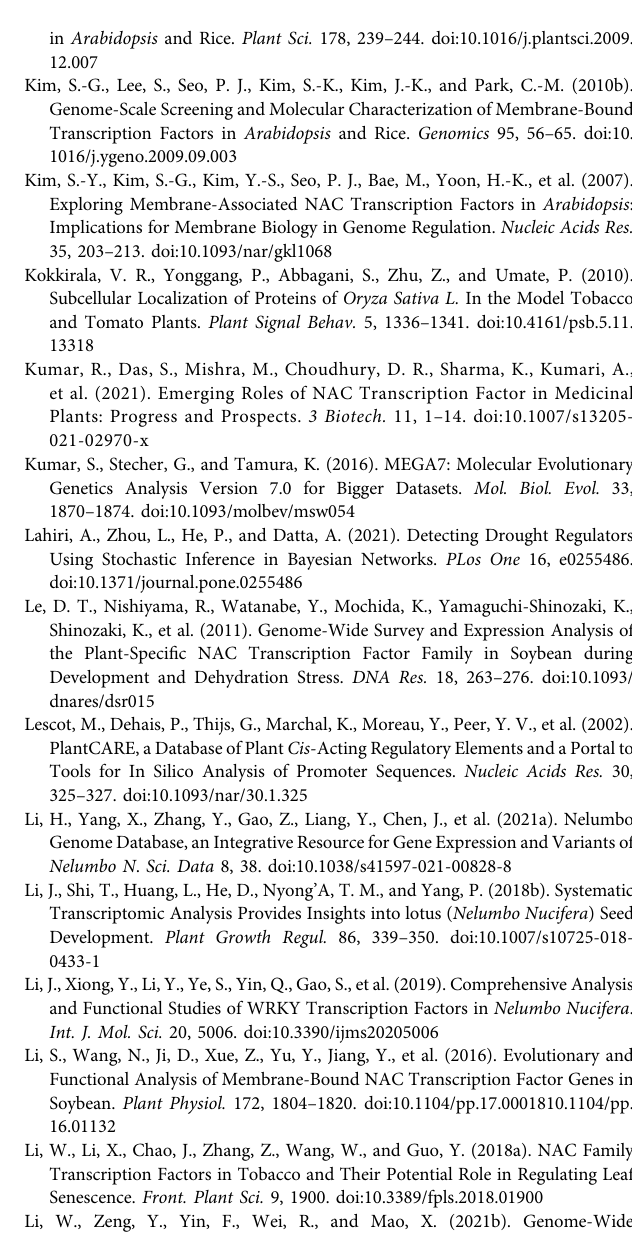
Supplementary Figure S1 | Structures of membrane-bound NnNAC proteins in lotus. Supplementary Figure S2 | Statistical summary of exon numbers in NnNAC genes. Supplementary Figure S3 | Chromosome localization of NnNAC genes in lotus. Supplementary Figure S4 | Comparison of NAC amino acid sequence similarities. Supplementary Figure S5 | Cis -element analysis in the promoters of NAC genes in lotus. Supplementary Figure S6 | Validation of gene expression through qRT-PCR. Supplementary Figure S7 | Phylogenetic relationship between NnNAC proteins and AtNAC proteins in Arabidopsis .